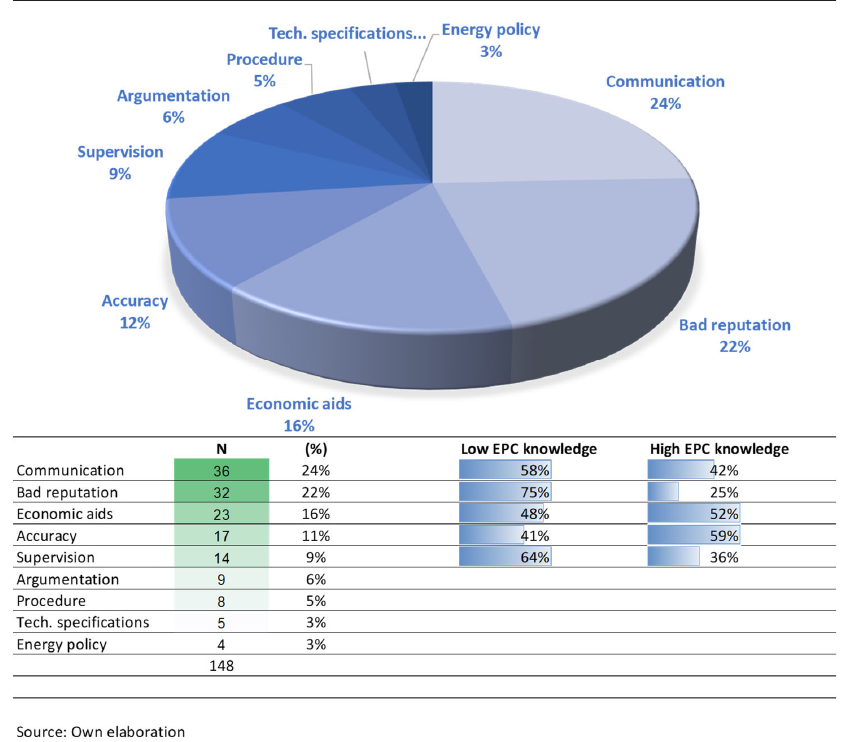
Figure 5. Perceived issues on implementation of the EPC scheme in Spain.